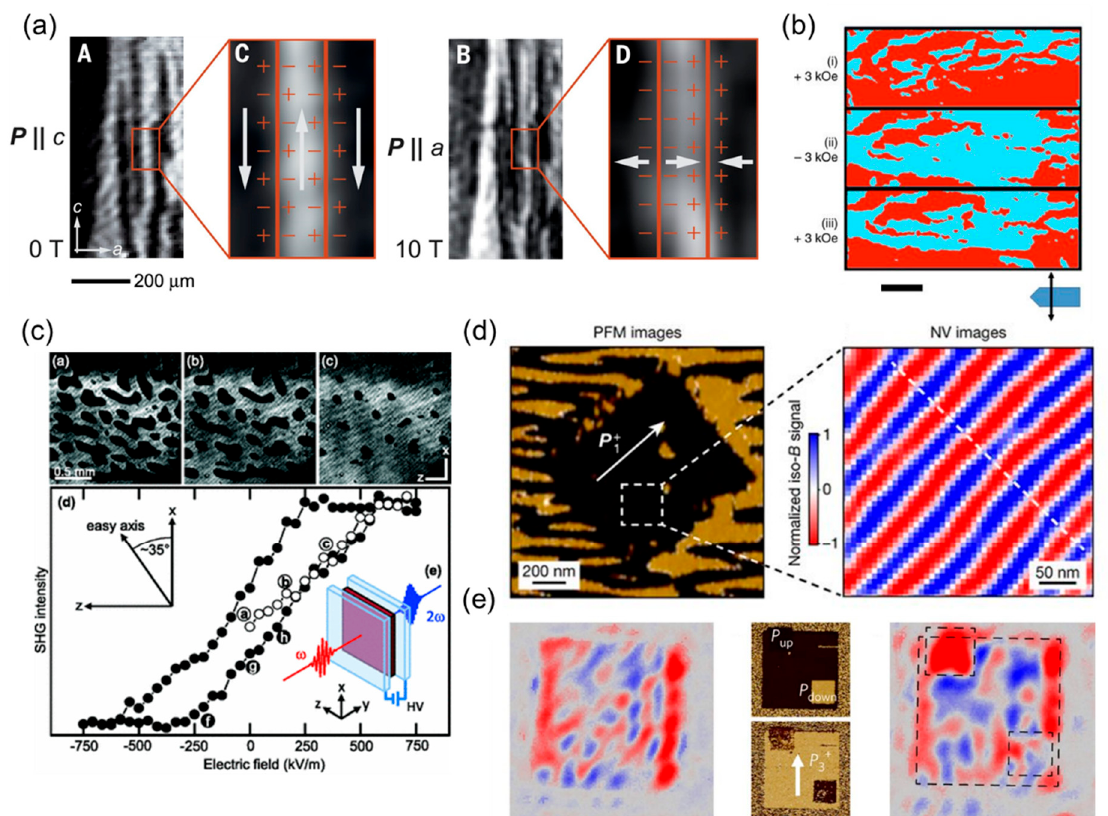
Figure 8. ( a ) SHG images of the polarization flop from Pc to Pa, driven by a reorientation of the spin-cycloidal plane from bc to ab with the application of a magnetic field. Reprinted with permission from [53], copyright AAAS, 2015. ( b ) PFM phase dependency on the orientation of the magnetic field applied to the PZTFT lamella. Growth of regions with polarization direction indicated by red with the application of 3kOe perpendicular to the lamellar surface, contraction of these regions with an application of -3kOe. Scale bar, 2 µ m. Reprinted with permission from [143]. ( c ) Evolution of the magnetic domain structure in multiferroic MnWO 4 during quasi-static electric-field poling and the SHG hysteresis loop. Reprinted with permission from [144], copyright the American Physical Society, 2011. ( d ) In-plane PFM image of ferroelectric micrometer-sized domains and the corresponding magnetic field distribution recorded with the scanning-NV magnetometer. ( e ) Antiferromagnetic configurations from SHG image of ferroelectric single domain state ( left ), the PFM images of a local application of an electric field ( middle ) and the SHG image of the antiferromagnetic configuration after the polarization switch ( right ). Reprinted with permission from [129], copyright Springer Nature, 2017.